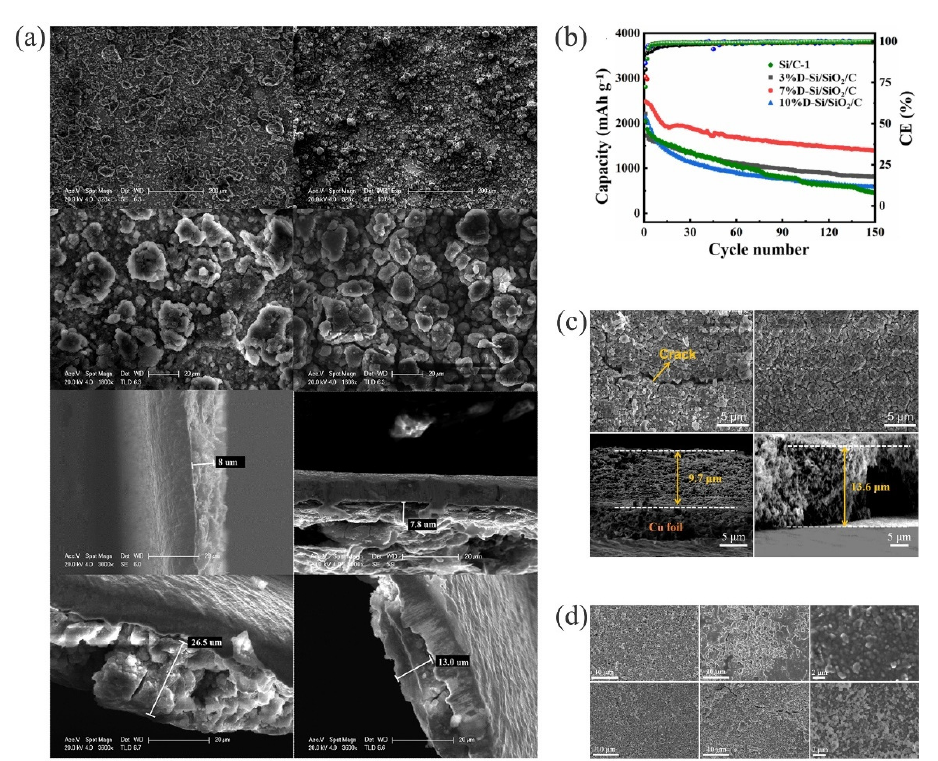
Figure 5. ( a ) SEM images of Si@C/rGO and Si@C/(15)Sn@C/rGO after 60 cycles and SEM images of cross-sections of Si@C/rGO and Si@C/(15)Sn@C/rGO, before and after 60 cycles [143]. Reprinted with